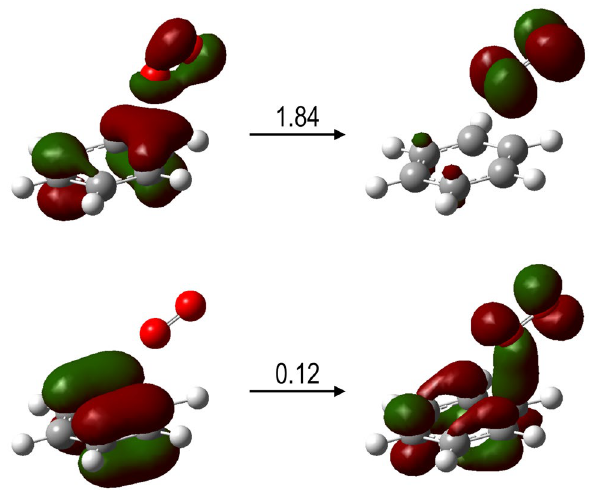
Figure 5. Natural transition orbitals (NTOs) analysis of the lowest energy excited state with charge transfer character C 6 H 6 2+ –O 2 , for R C-O ≈ 2 Å. The two component transitions of this excited state as obtained with NTO are given with the corresponding coefficient, showing charge transfer from benzene to O 2